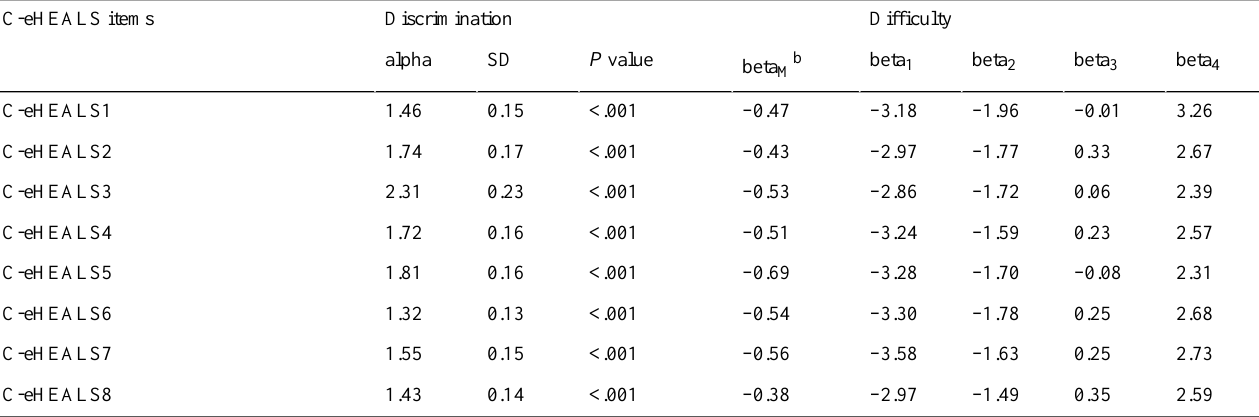
Table 4. Item Response Theory model parameters from C-eHEALS Graded Response Modelsa. DifficultyDiscriminationC-eHEALS